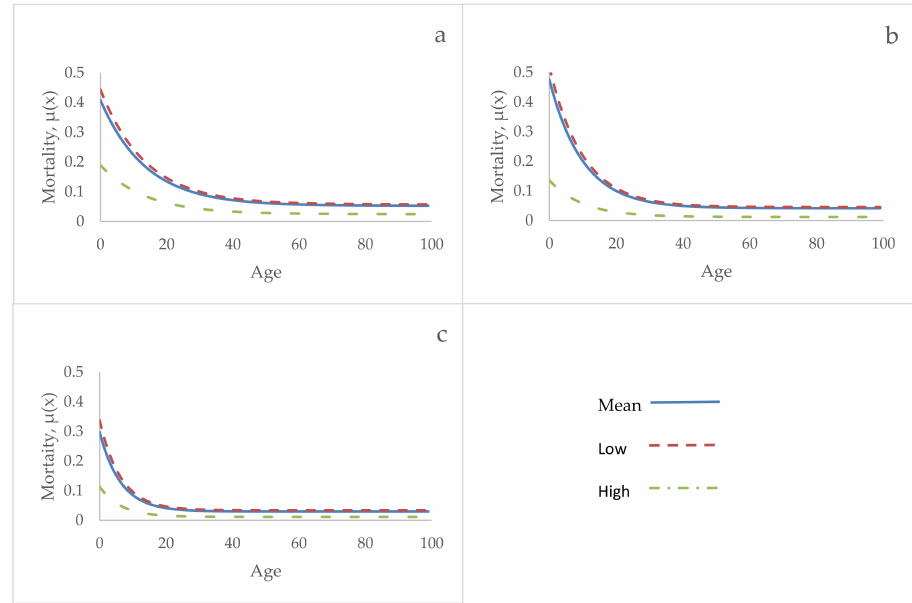
Figure 3. Age trajectories of mortality as function of di ff erent levels of reproductive output (mean, low (2.5th percentile) and high (97.5 th percentile)) at site 1–3 ( a – c ) using the Gompertz Makeham model. Mortality is presented from germination to the age where the population from the site with the lowest mortality (site 3) reaches 1% of its original size (Figure A1). Mean = 0.040, 0.042, 0.061, Low = 0, High = 0.41, 0.65, 0.53 flowers / year at sites 1–3,